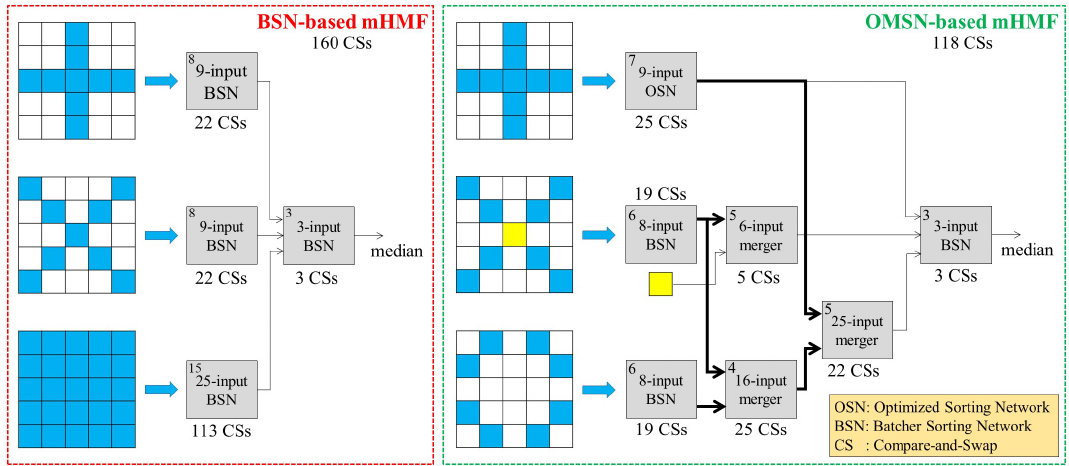
Figure 16. Previously developed and the newly proposed architectures for a 5 × 5 mHMF.